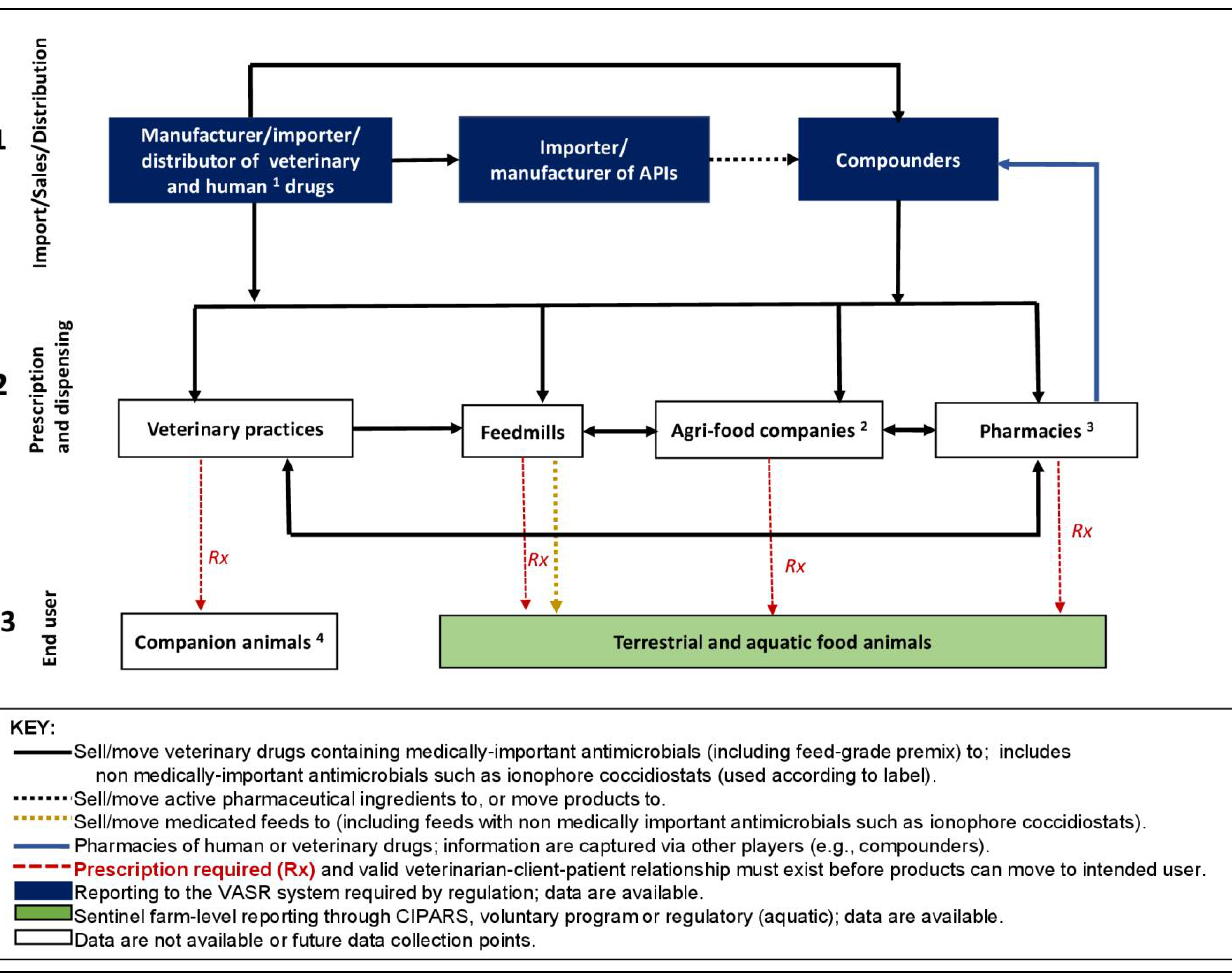
Figure 1. The antimicrobial supply distribution pathway in Canada indicating the existing and future antimicrobial use data collection points. VASR — Veterinary Antimicrobial Sales Reporting system. CIPARS — Canadian Integrated Program for Antimicrobial Resistance Surveillance. 1 Human drugs intended for use animals (largely companion animals). 2 Veterinarians in agrifood companies (corporate veterinarians) prescribe antimicrobials for use in relevant production phases as part of the coordinated supply chain within their network (e.g., hatcheries, breeders, grower farms, and feedmill). 3 Pharmacies of veterinary drugs and human drugs intended for use in animals (i.e., pharmacies of in where they are dispensing antimicrobials). 4 Companion animals include